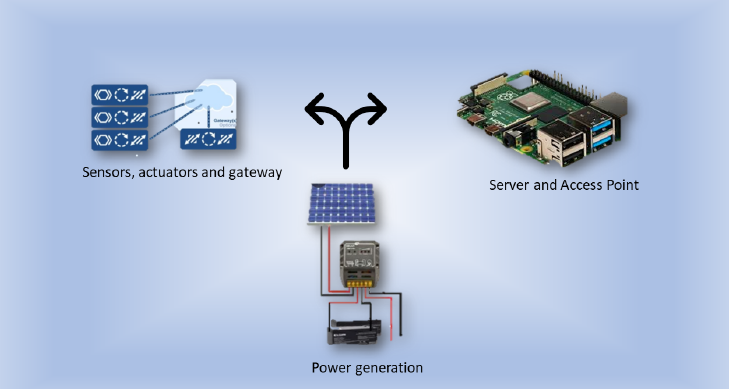
Figure 1. Station